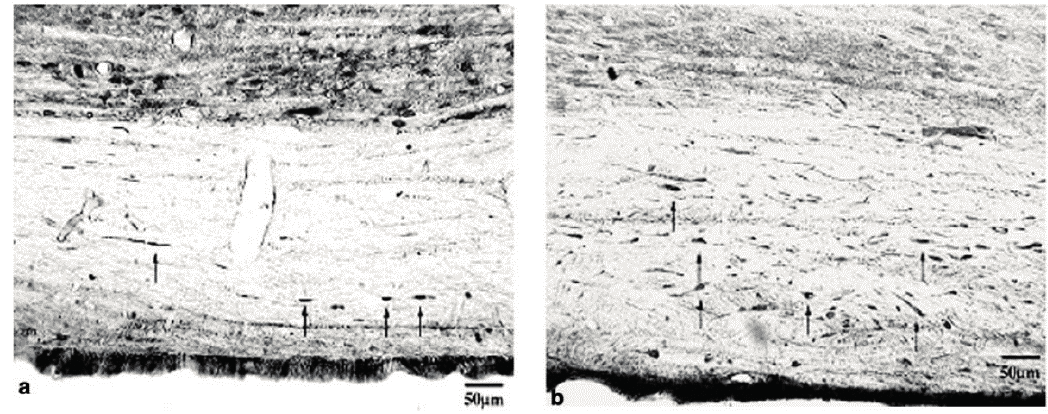
Figure 5. In these light microscopic images, we see the protective effects of hypothermic intervention followed by slow rewarming ( a ) versus the damaging effects associated with hypothermia followed by rapid rewarming ( b ) In both a and b, the damaged immunoreactive axons are labeled with arrows, with a striking demonstration of reduced axonal burden in a versus b . Reprinted with permission from [152], copyright Mary Ann Liebert, Inc.,